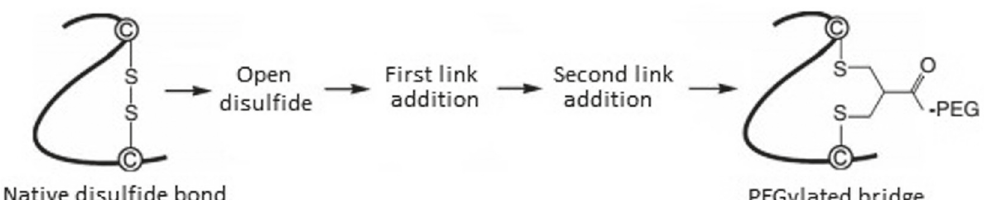
FIGURE 7 - Schematic mechanism for a disulfide site-specific